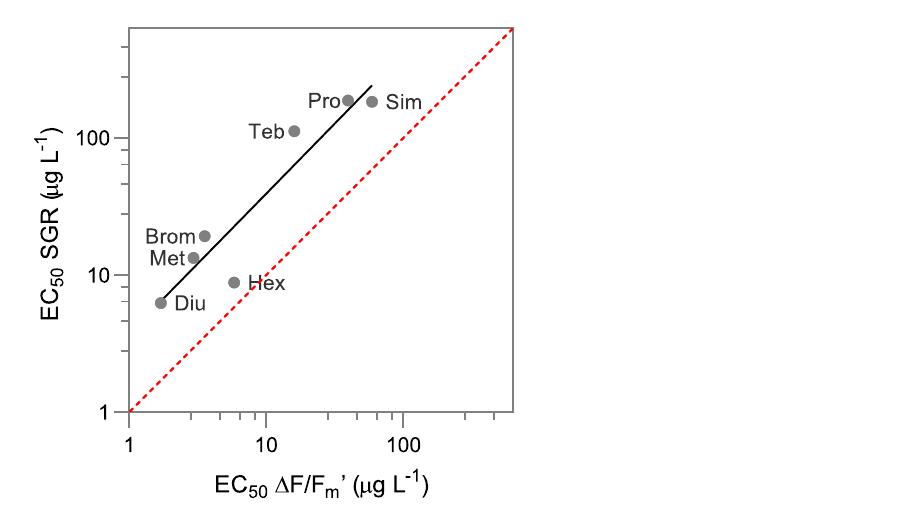
Figure 4. Linear relationship between effective quantum yield ( Δ F/F m ′ ) and specific growth rate (SGR). Comparison of EC 50 values (Slope = 3.48; R 2 = 0.87) of seven PSII inhibitor herbicides (Diu – diuron, Met